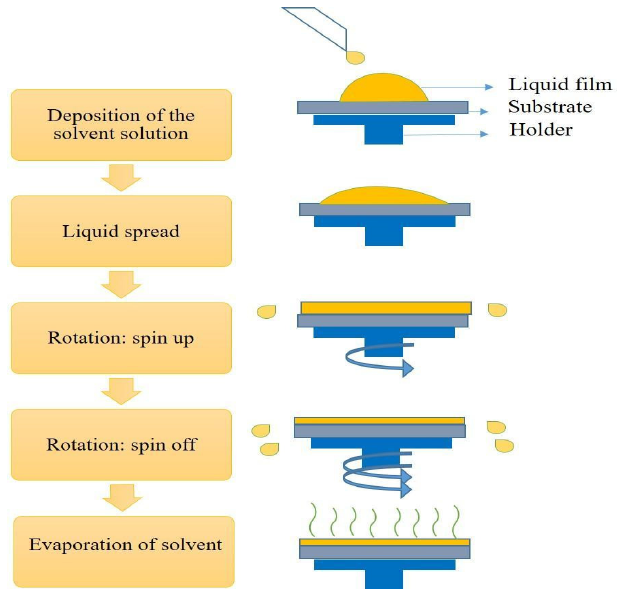
Figure 12. Schematic overview of spin-coating method.